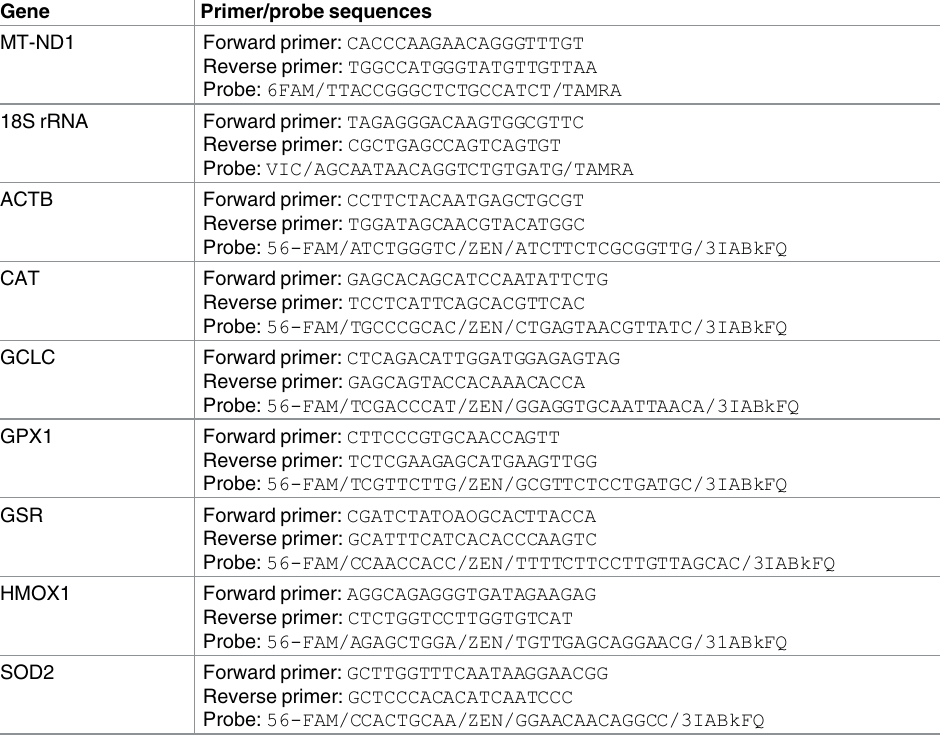
Table 1. Primers and probes used for semiquantitative